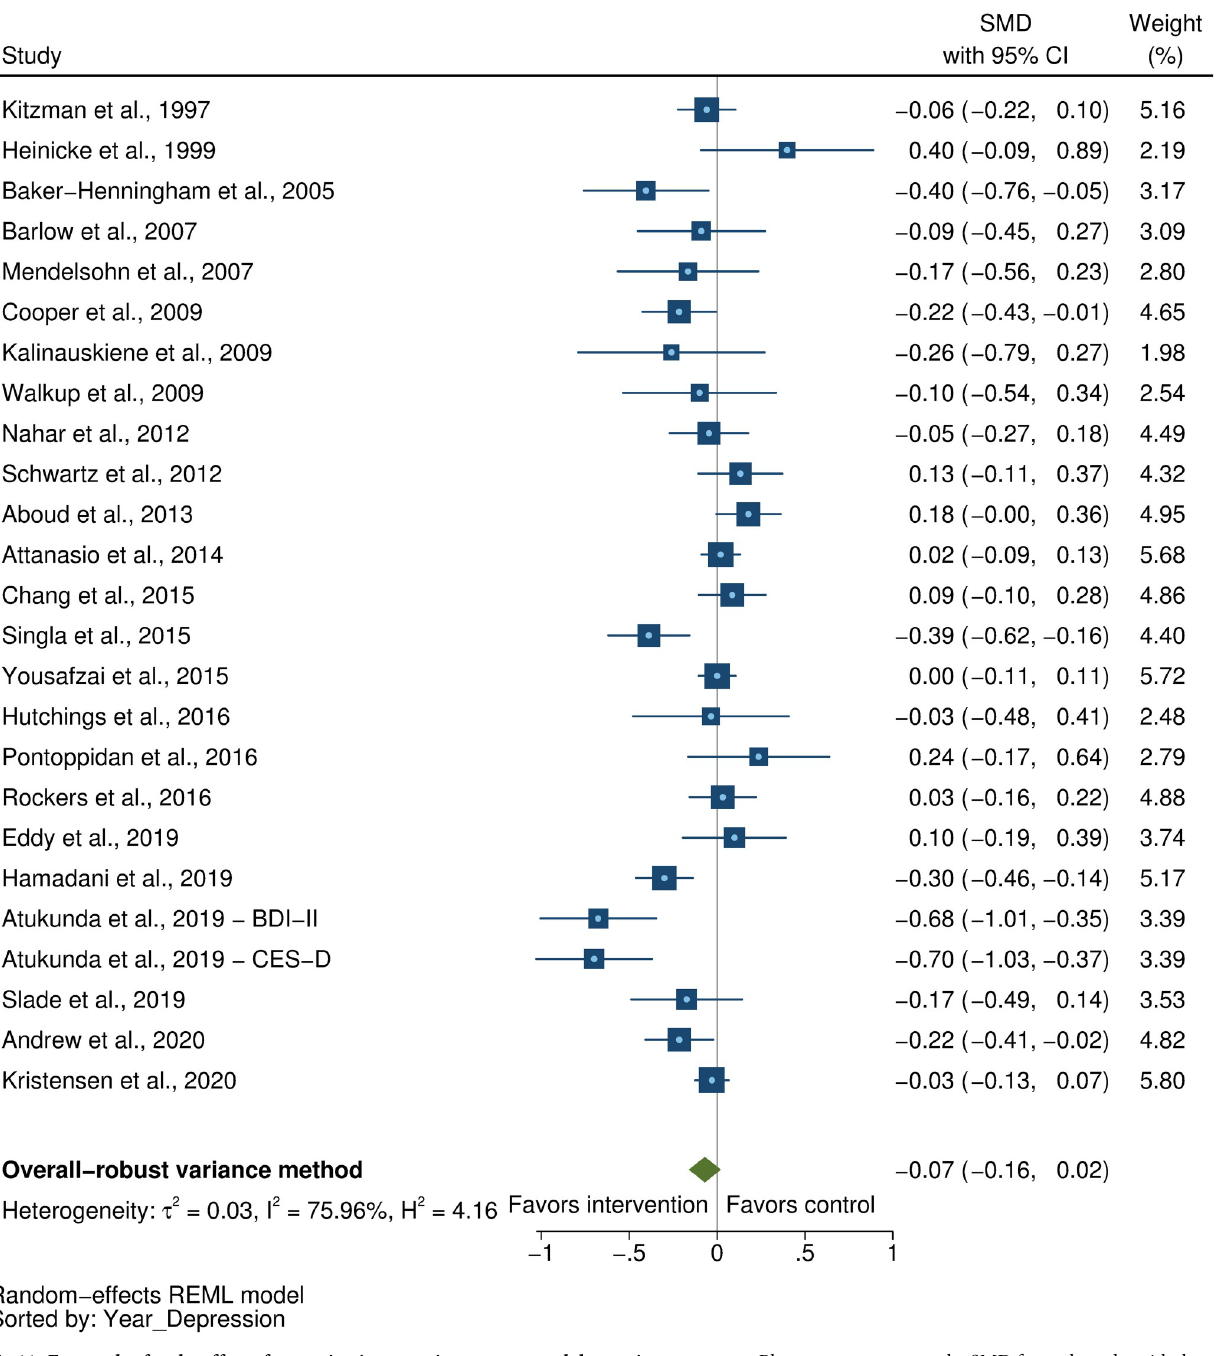
PLOS Medicine| https://doi.org/10.1371/journal.pmed.1003602 May 10, 2021 34 /